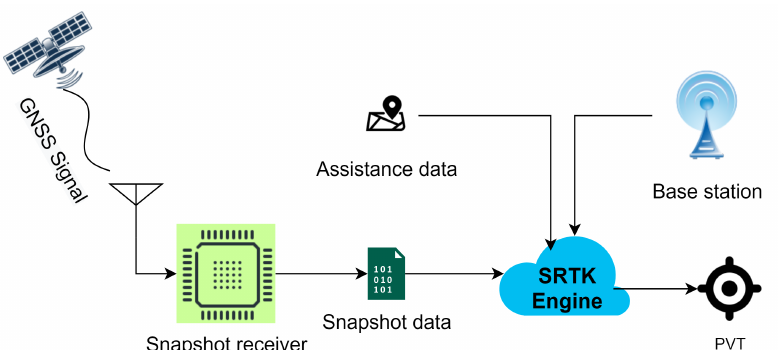
Figure 1. General workflow of cloud-based GNSS